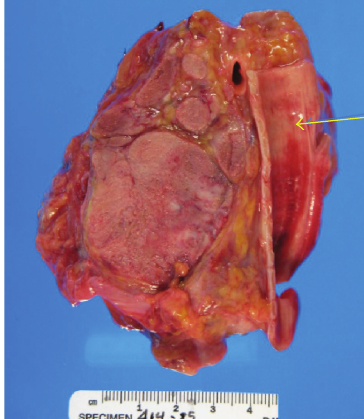
Figure 7: Massive enlargement of ovary (arrow) and uterus from extensive tumor infiltration.